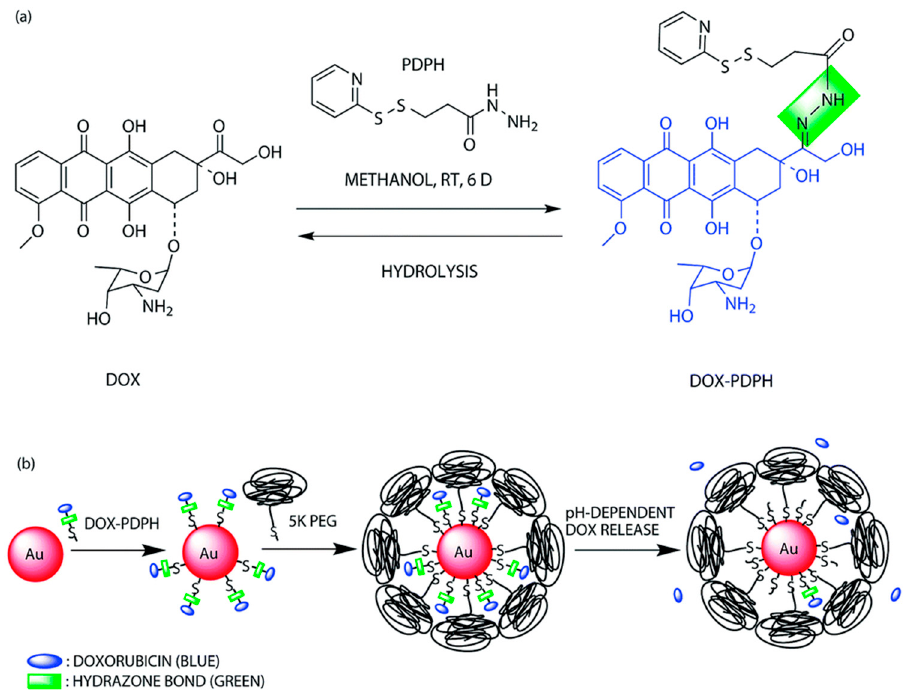
Figure 4 . A pH-sensitive drug-gold nanoparticle system. ( a ) Chemical synthesis of the doxorubicin-hydrazone linker conjugate (dox–PDPH). ( b ) Schematic illustration for the synthesis of the multifunctional drug delivery system and its pH-dependent doxorubicin release. Reproduced with permission from Kate Y. J. Lee, Yiqing Wang, and Shuming Nie, RSC Advances; published by Royal Society of Chemistry, 2015.